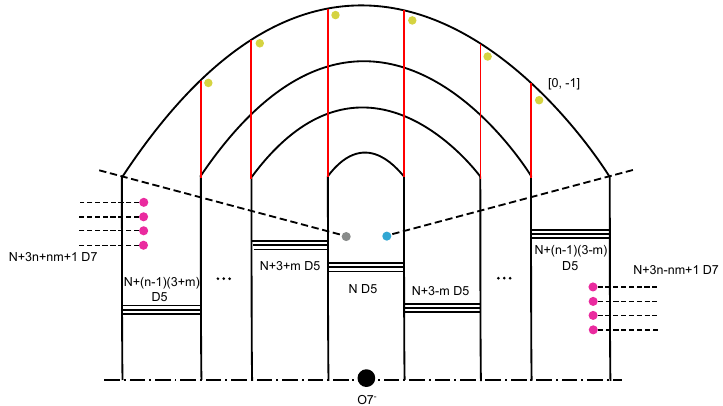
Figure 28 . The schematic diagram after moving the branch cuts of B ; C and X 7-branes in the case when one resolves one of the O 7 (cid:0) -planes in (cid:12)gure 23. The motion corresponds to the upper ones depicted in (cid:12)gure 25.